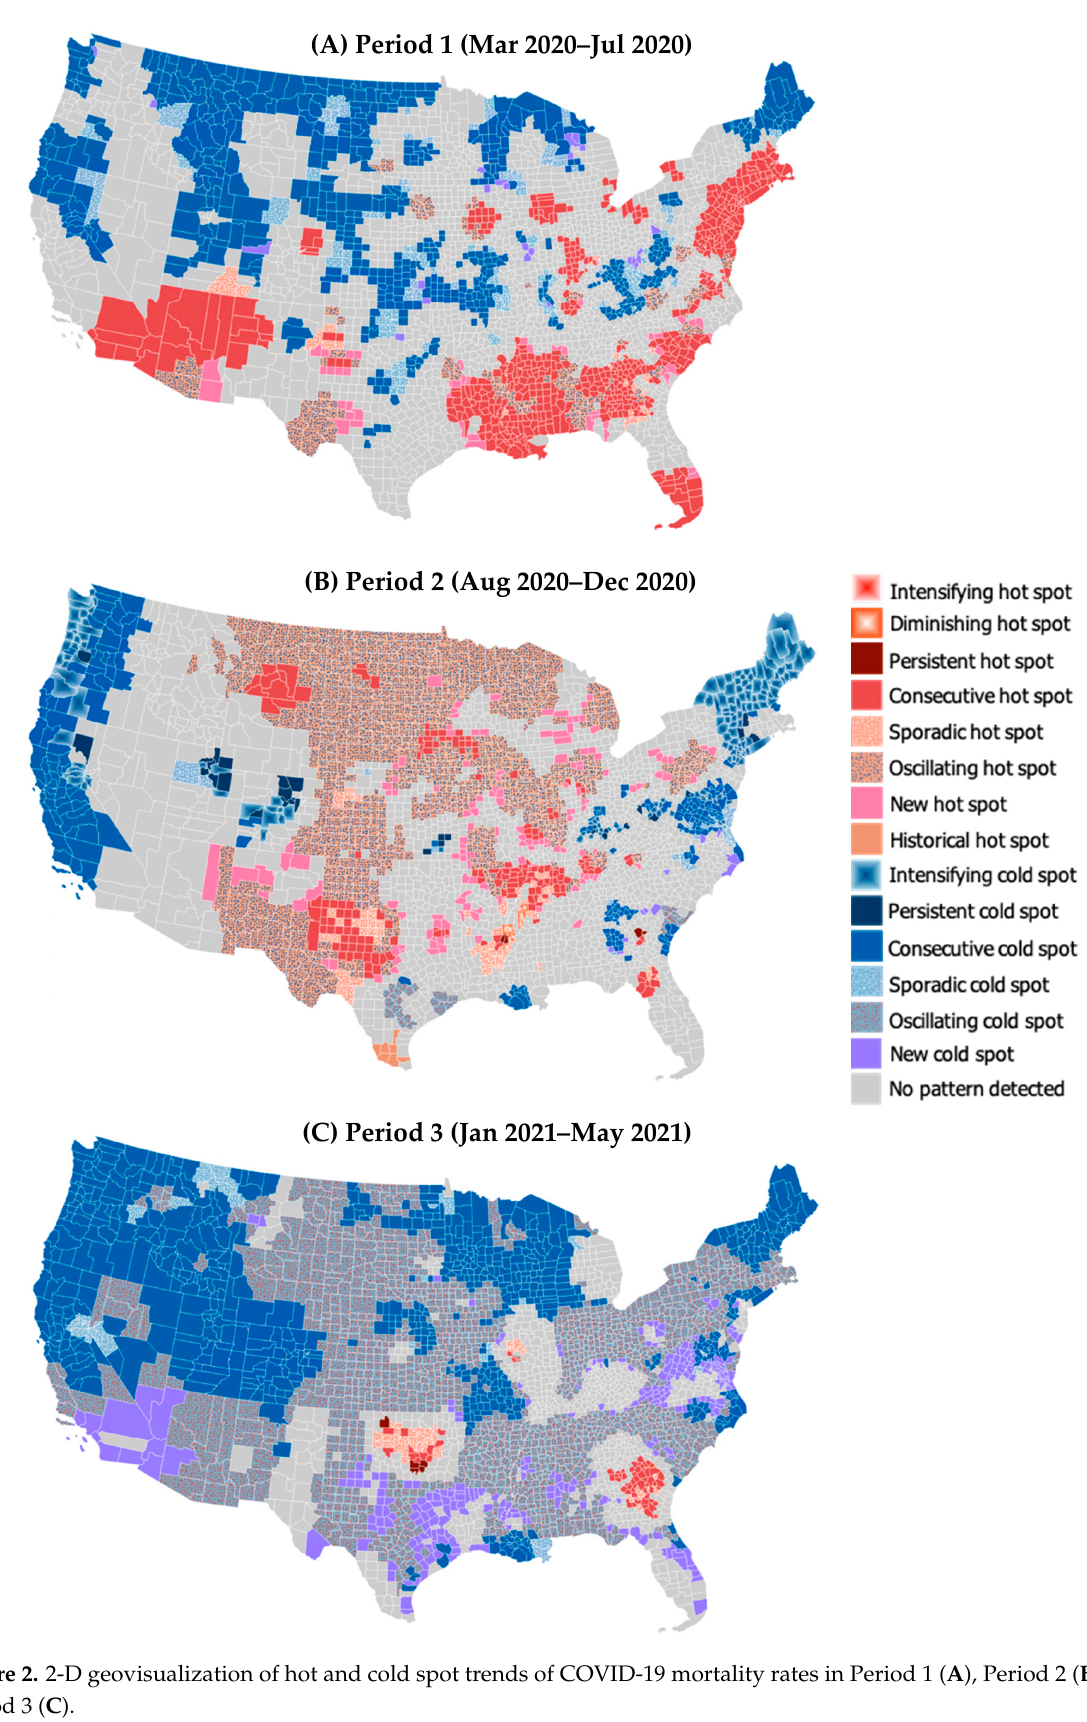
Figure 2. 2-D geovisualization of hot and cold spot trends of COVID-19 mortality rates in Period 1 ( A ), Period 2 ( B ), and Period 3 ( C ).